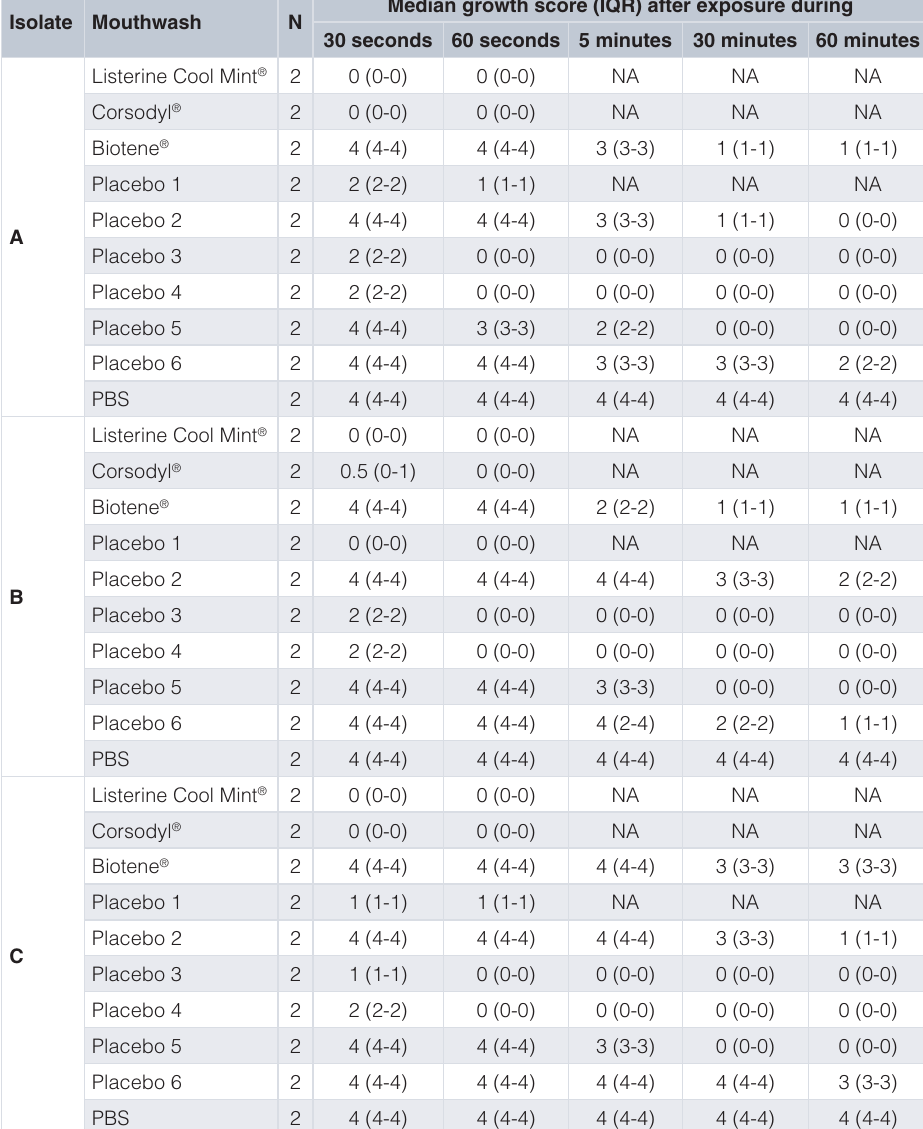
Isolate Mouthwash